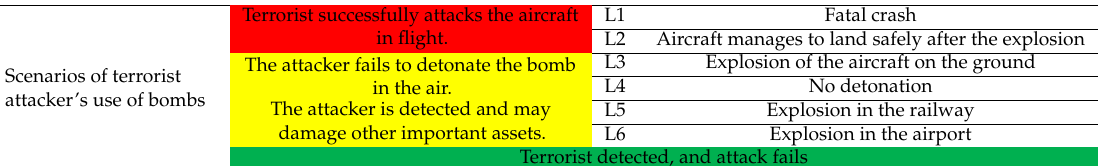
Table 2. The consequences and losses’ scenarios of a terrorist attack using bombs. The color represents the risk level (red: high; yellow: medium; and green: